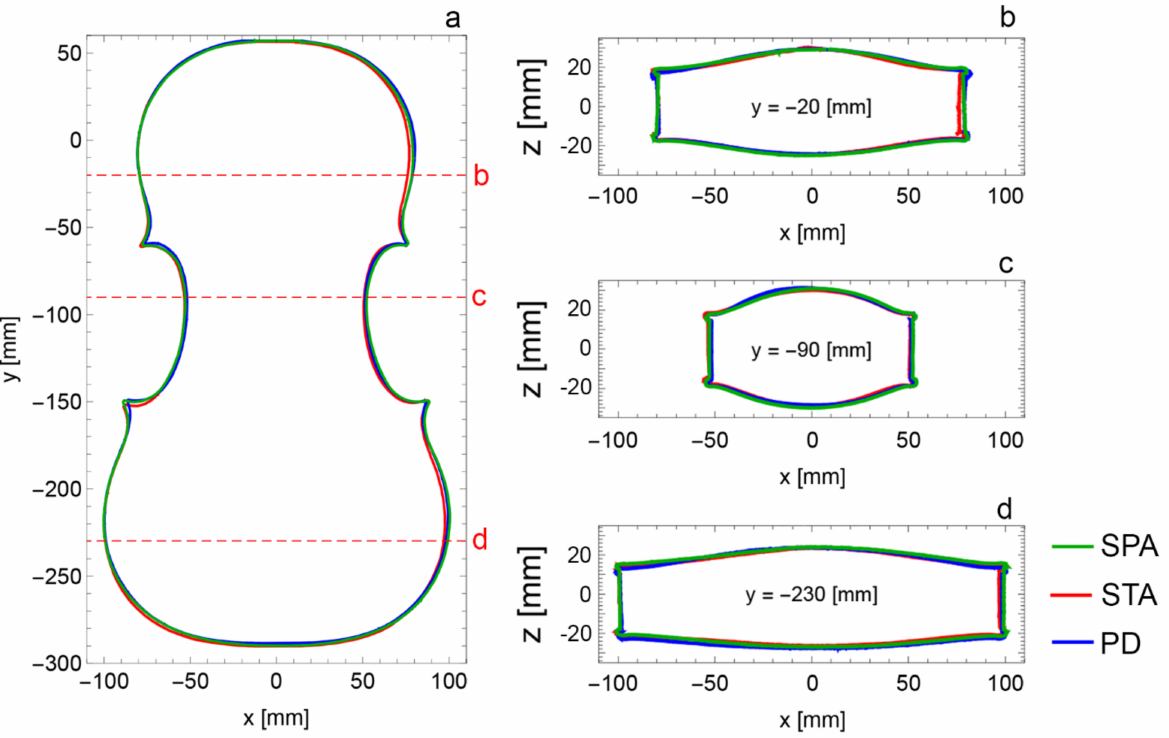
Figure 5. Outlines ( a ) and cross sections at different y locations ( b – d ) of the “Spagnoletti” (SPA, green line), the “Stauffer” (STA, red line), and the “Principe Doria” (PD, blue